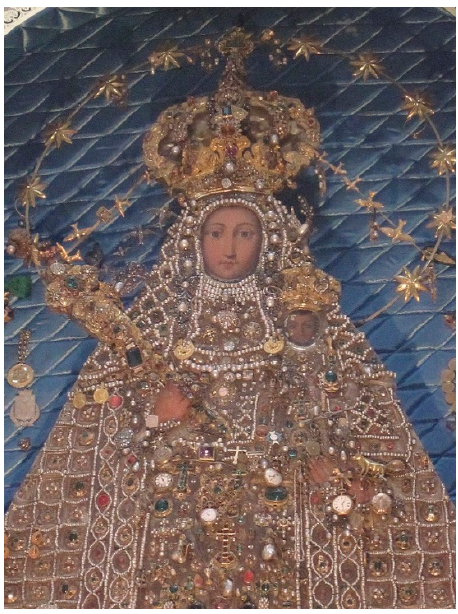
Figure 2. Detail, Virgin of Guadalupe (photo: Andrea Nicklisch).